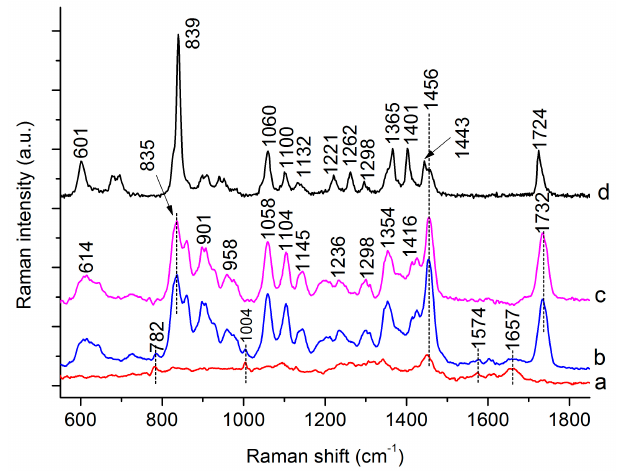
Figure 1. Single-cell Raman spectra from Cupriavidus necator H16 cells cultured for 24 h (a,b) or 2 h (c,d). Spectra were acquired from cells while trapped (a,c) or adhered onto quartz cover (b,d) by laser tweezers Raman spectroscopy (LTRS). Curves c and d were amplified by factor of two.